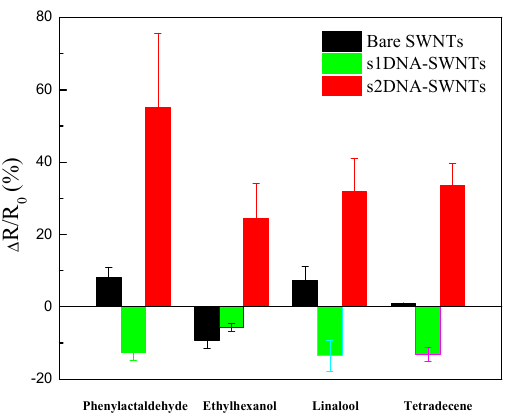
Figure 7. Histogram showing comparison of responses of bare SWNTs before and after being functionalized with ssDNA toward phenylacetaldehyde, ethylhexanol, linalool, and tetradecene (100% saturated vapors). Each data point is an average of measurements from four independent biosensors.